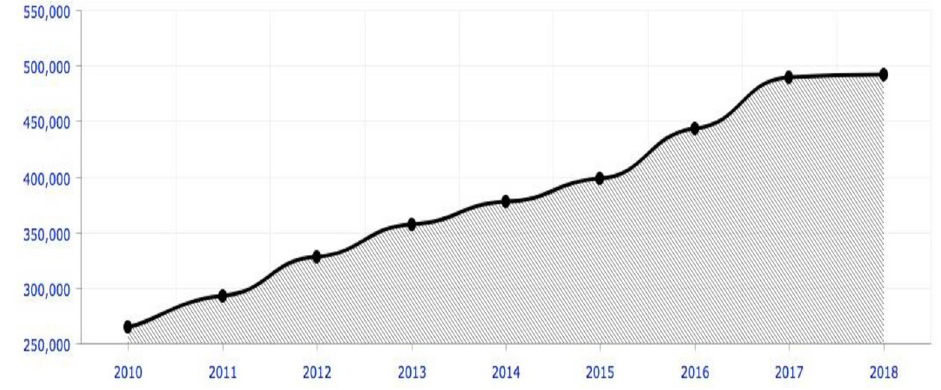
Fig 1. Number of international students in Chinese universities (2010–2018). Source: Chinese Ministry of Education (MoE) Statistics Yearbook